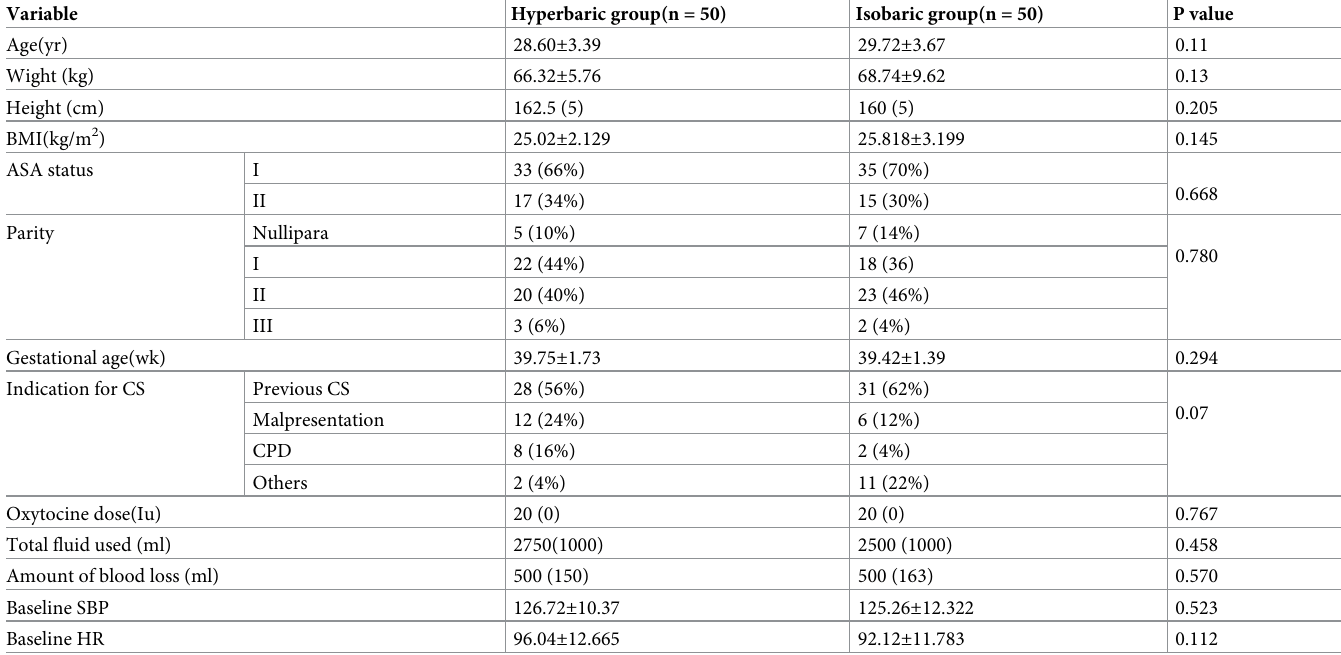
Table 1. Demographic data, perioperative variables among groups at Gandhi Memorial Hospital, Addis Ababa, Ethiopia, 2018. Variable